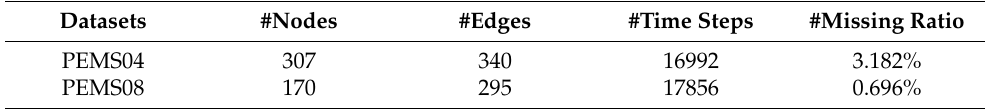
Table 1. Dataset description and